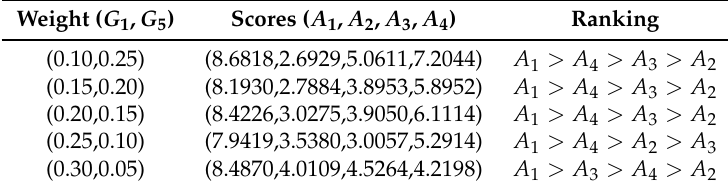
Table 20. The ranking of the network security system.